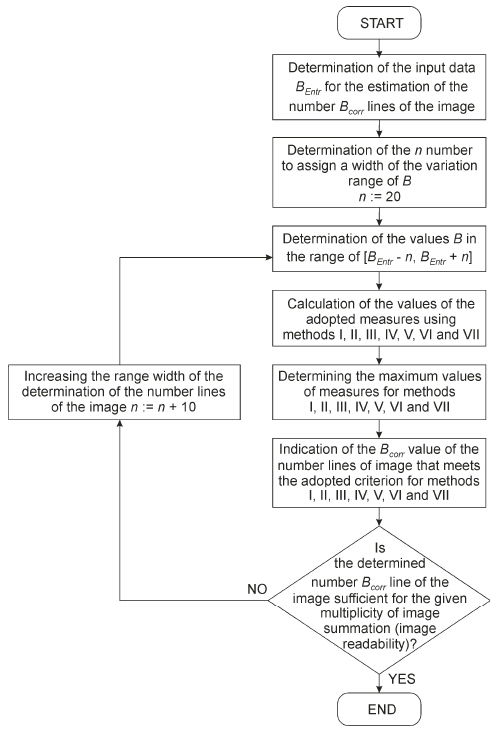
Figure 9. An algorithm for determining the correct number lines of a reconstructed image.